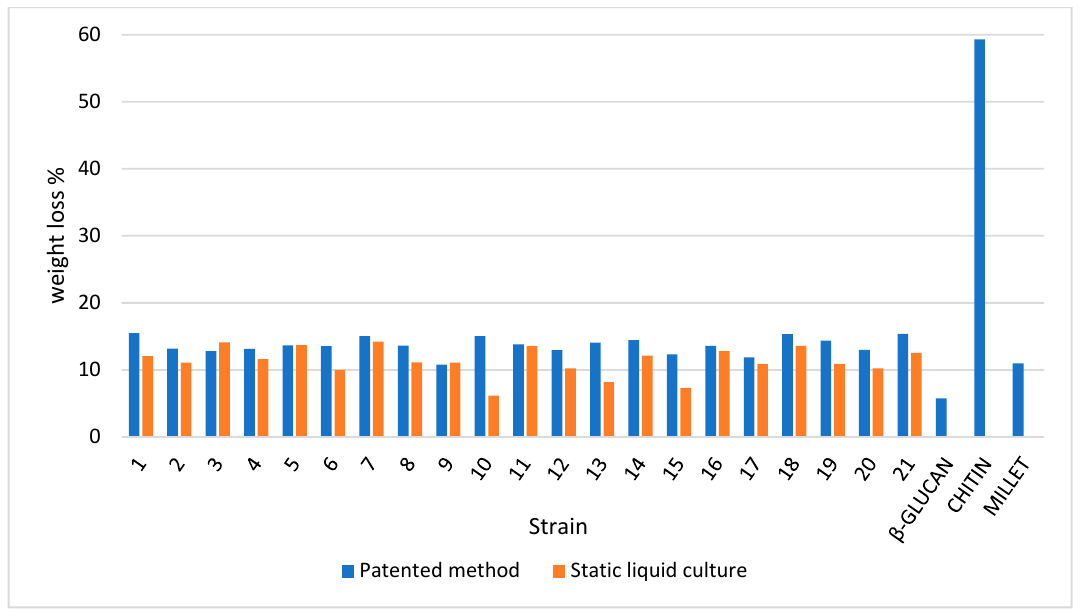
Figure 7. Weight loss percentage for the dry samples in the 250–350 °C temperature range (TGA output) in the mycelium (pure mycelium and slurry mat) and reference materials.